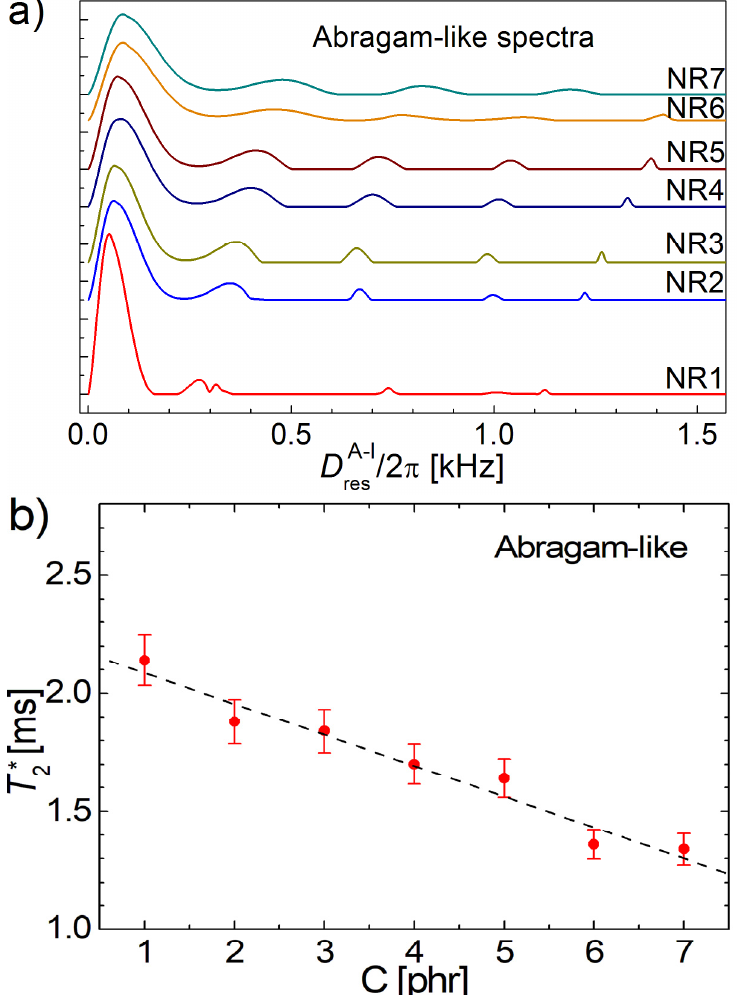
Figure 14. ( a ) The inverse Abragam-like spectra (Equation (21)) with the kernel Equation (22), showing the distributions of (cid:1830) (cid:3045)(cid:3032)(cid:3046)(cid:3002)(cid:2879)(cid:3039) /2(cid:2024) for the series of six year natural aged of the cross-linked natural rubber. ( b ) The effective transverse relaxation time as a function of cross-link density obtained from the best fit of the normalized 1 H DQ build-up curves using the inverse Abragam-like transformation. The dashed line represents the best line of fit of the data for the samples NR1 to NR7.